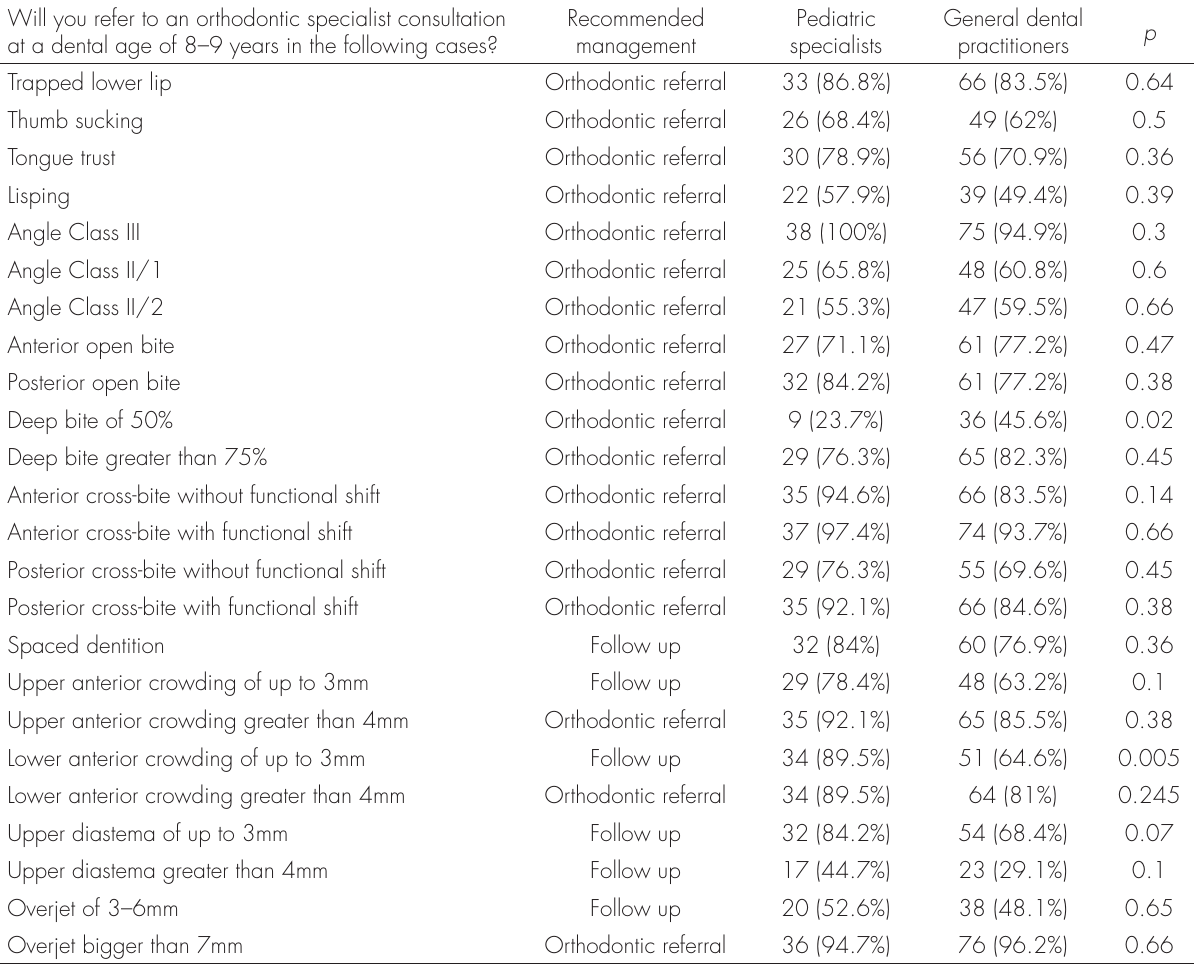
Table III. Orthodontic referral pattern of pediatric specialists and general dental